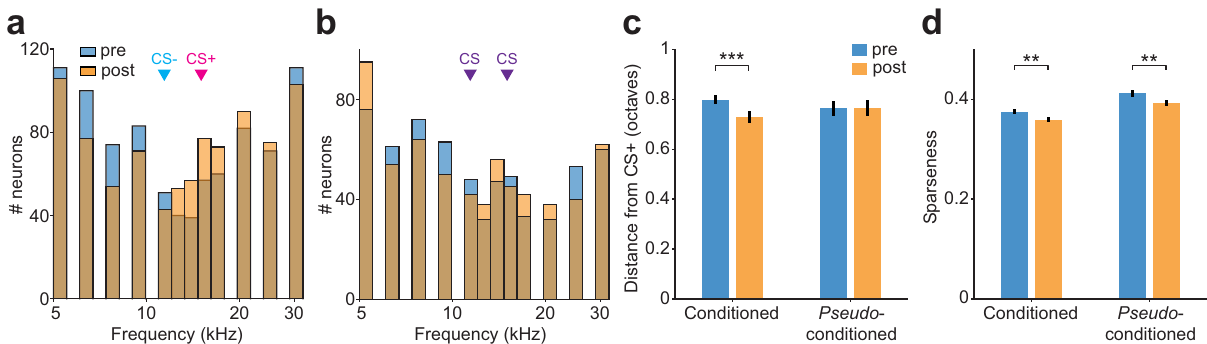
Fig. 6 Best frequency and tuning sparseness pre- and post-conditioning. a Distributions of best frequencies of responsive neurons pre- (blue) and post- conditioning (orange), N = 879. b Same as ( a ) for pseudo -conditioned mice, N = 626. c Mean (±sem) distance of best frequency from CS + (15 kHz) of neurons from conditioned ( n = 879, N = 14 mice) and pseudo -conditioned ( n = 626, N = 9 mice) mice pre- (blue) and post-conditioning (orange). Statistics: two-way rm-ANOVA Tukey – Kramer post hoc analysis *** p < 0.001 (Supplementary Table 1). d Mean (±sem) sparseness of mean frequency response functions of neurons from conditioned ( n = 879 neurons, N = 14 mice) and pseudo -conditioned ( n = 626, N = 9 mice) mice pre- (blue) and post- conditioning (orange). Statistics: two-way rm-ANOVA Tukey – Kramer post hoc analysis ** p = 0.001 (Supplementary Table 1). Source data are provided